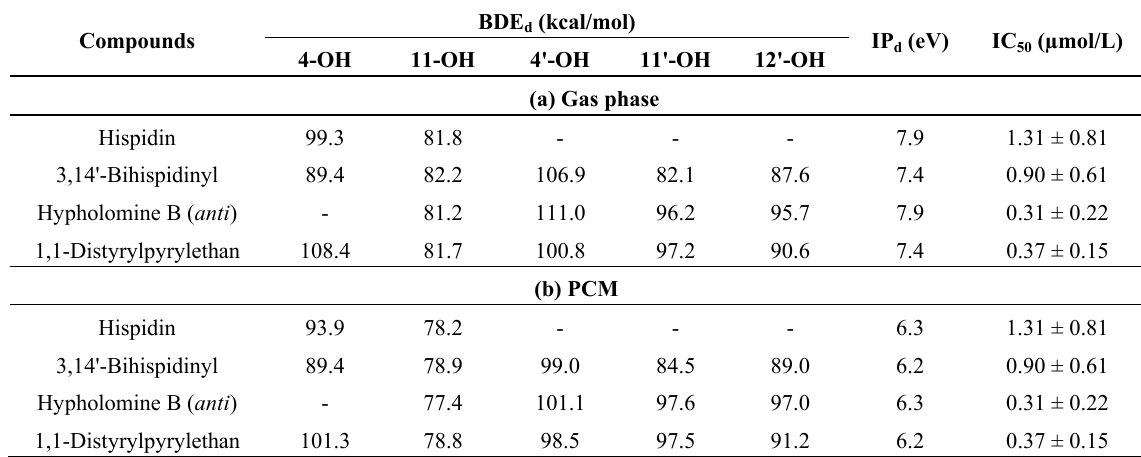
IP d (eV) IC 50 (µmol/L)